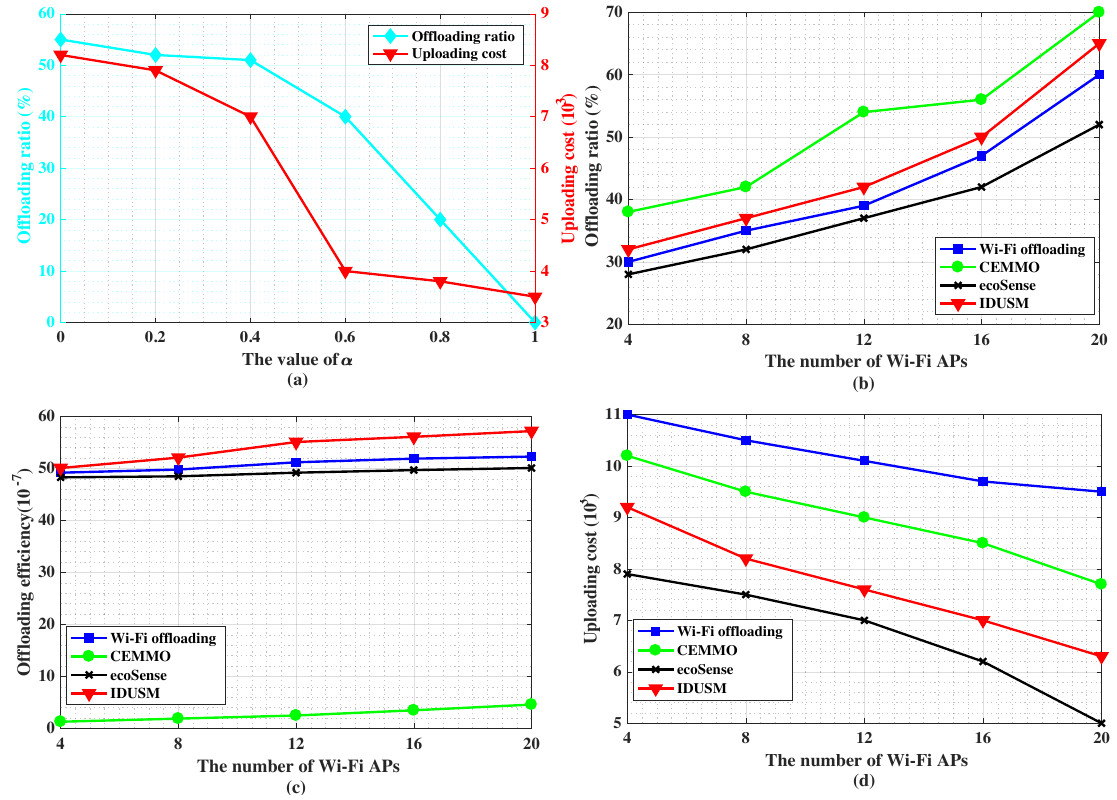
Figure 7. ( a ) The influence of the value of α on the performance of IDUSM. ( b ) The impact of the number of Wi-Fi APs on offloading ratio. ( c ) The impact of the number of Wi-Fi APs on offloading efficiency. ( d ) The impact of the number of Wi-Fi APs on uploading